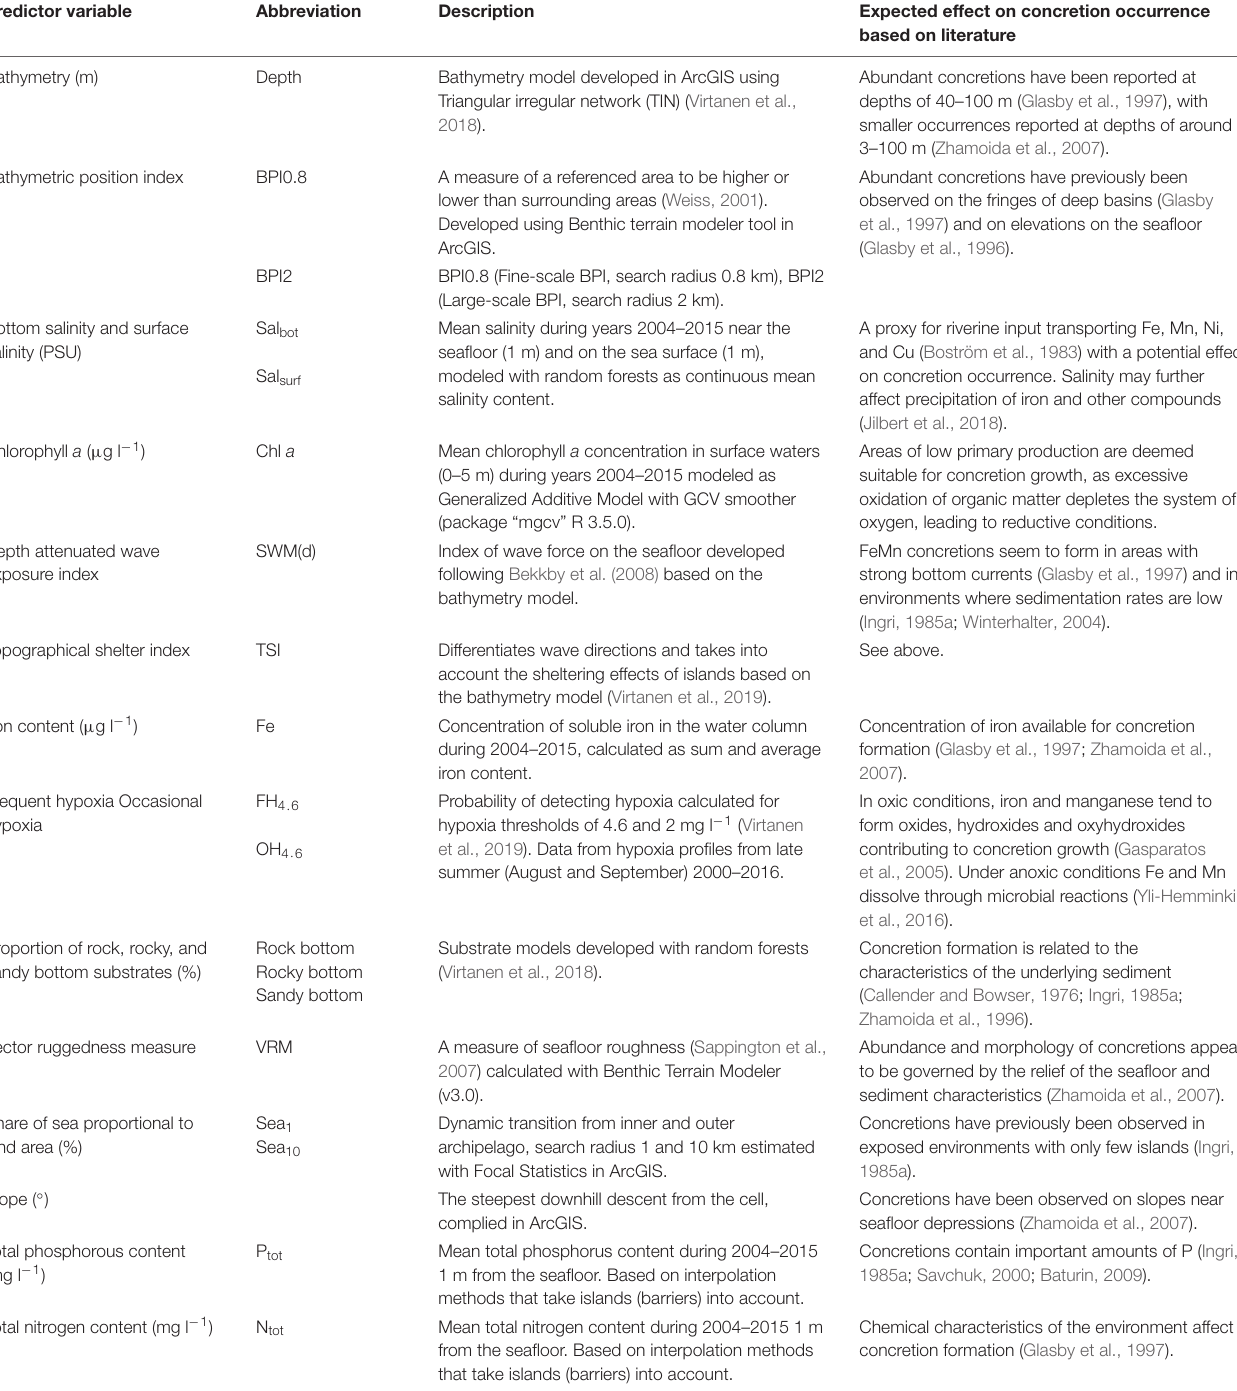
TABLE 1 | Environmental predictors used in modeling the distribution of FeMn